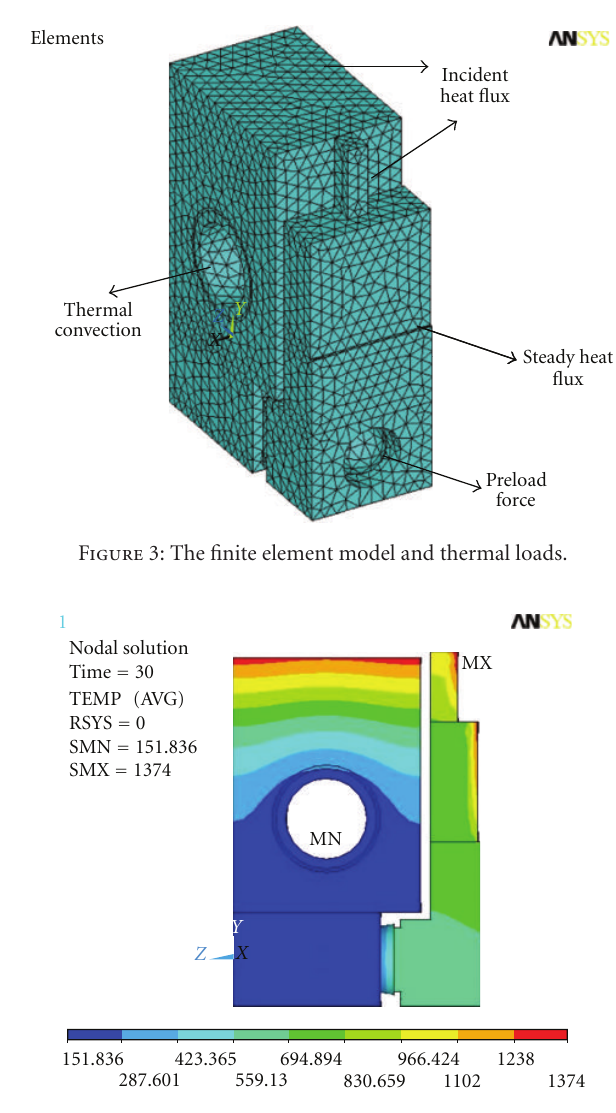
Figure 4: The 30s thermal field of